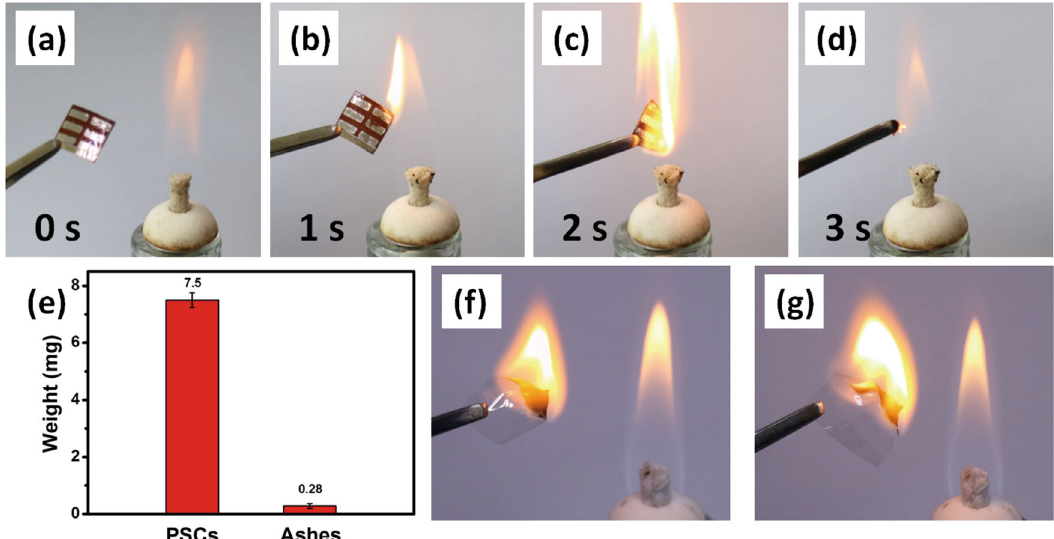
Fig. 5 The burning process of the NCP-based PSCs for a 0 s, b 1 s, c 2 s, and d 3 s. e The weight of the cell before and after incineration. Each data point is the mean of seven measurements. Digital photographs of f NCP and g NCP-based substrate with coating of acrylic resin being burnt by fl ame (1.3 cm × 1.3 cm square